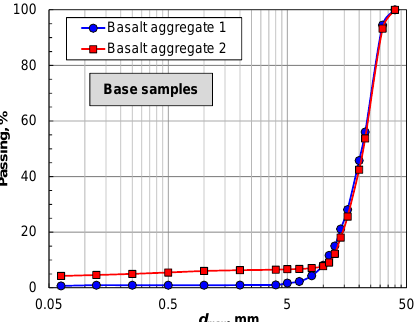
Figure 4. Grain classification scheme of samples before and after crushing.